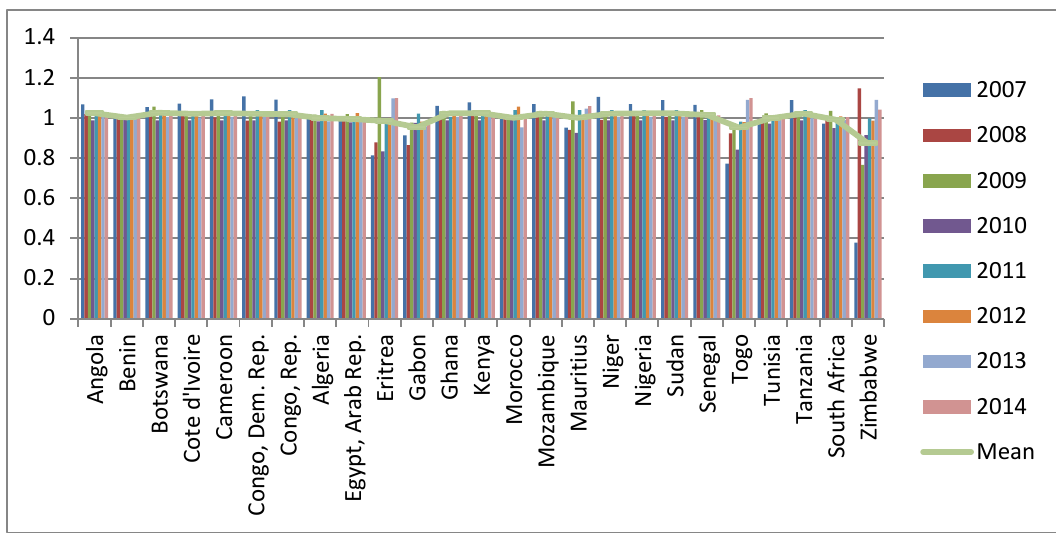
Figure 9. The technology change estimates in Africa from 2006–2014.